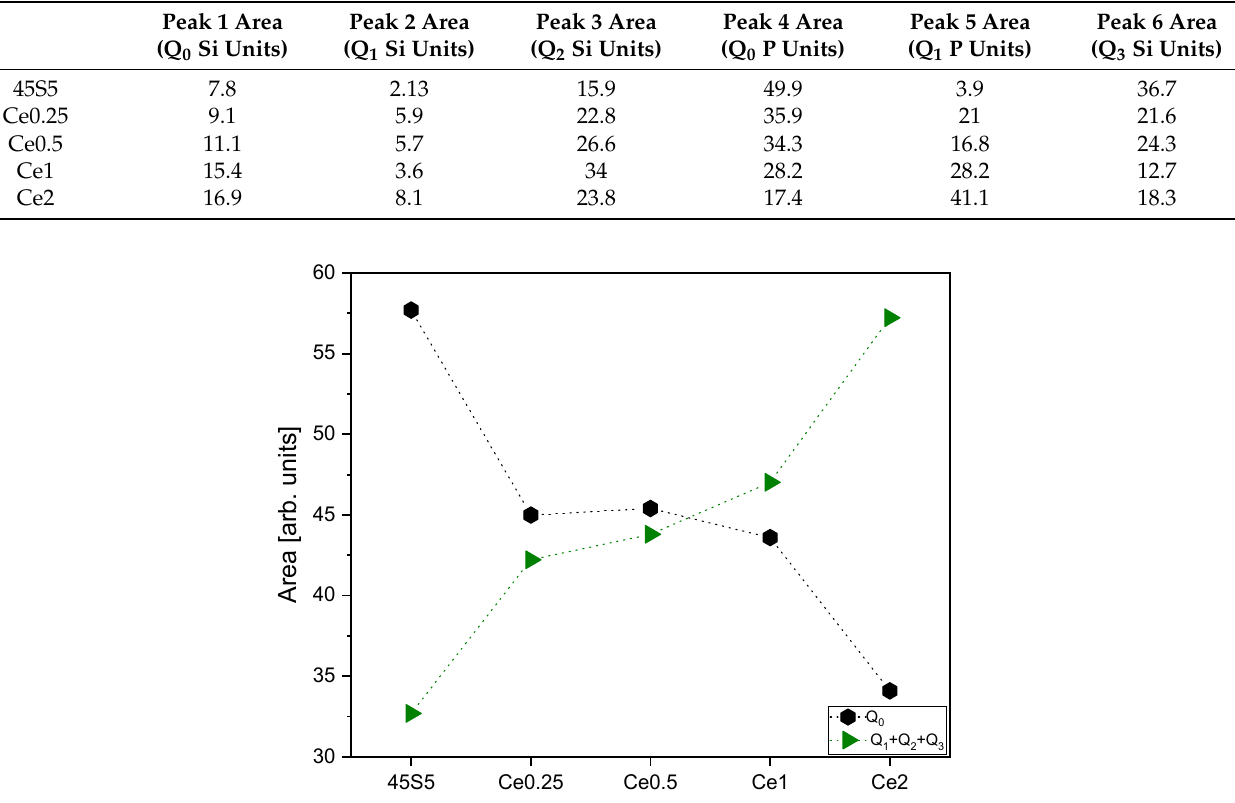
( b ) Figure 6. The logarithm of conductivity versus 1000/T, for all samples in the ( a ) dc regime and ( b ) ac regime, at 10 kHz. Table 2. Values of dc and ac conductivity and respective activation energies, and the permittivity at 10 kHz and 300 K. 𝝈 𝒅𝒄 (10 − 10 ) [S/m]